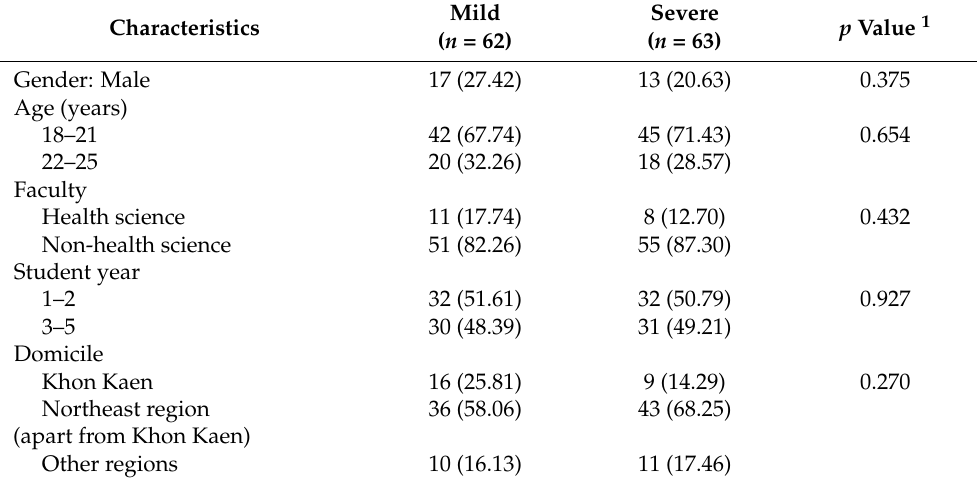
Table 1. Demographic characteristics for those who had mild versus severe mental health problems.